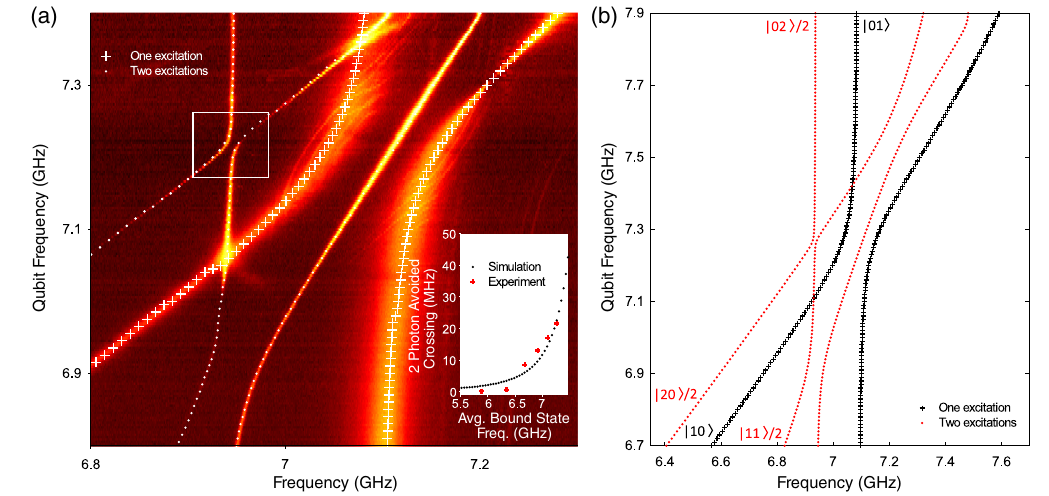
FIG. 4. Interaction between two-excitation levels of two bound states. — (a) Spectroscopic measurement while tuning one bound state through the other (qubit fixed at 7.2 GHz), reveals survival of strong interaction into the two-excitation manifold. Crossed and dotted lines are guides to the eye to discern the levels belonging to the first ( j 01 i and j 10 i ) and second ( j 02 i , j 20 i , and j 11 i ) excitation manifolds, respectively. Here, we have labeled our states as j transmon one ; transmon two i . In addition to the j 02 iðj 20 iÞ and j 11 i avoided level crossing, we also detect a two-photon virtual interaction between j 02 i and j 20 i (white box). This interaction — fourth order in coupling g — manifests itself in avoided level crossings up to and exceeding 20 MHz. For comparison, the j 02 iðj 20 iÞ - j 11 i and j 01 i - j 10 i interactions are second order in g and thus both are significantly stronger. Inset: two-photon avoided crossing strength versus average bound-state frequency. (b) Numerical simulation for fixed bare qubit frequency of 7.27 GHz, with the one (two) excitation manifold in black